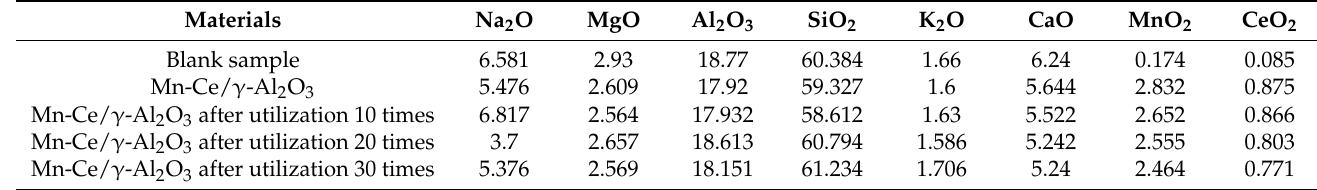
Table 2. XRF characterization of Mn-Ce/ γ -Al 2 O 3 catalyst (wt, %).